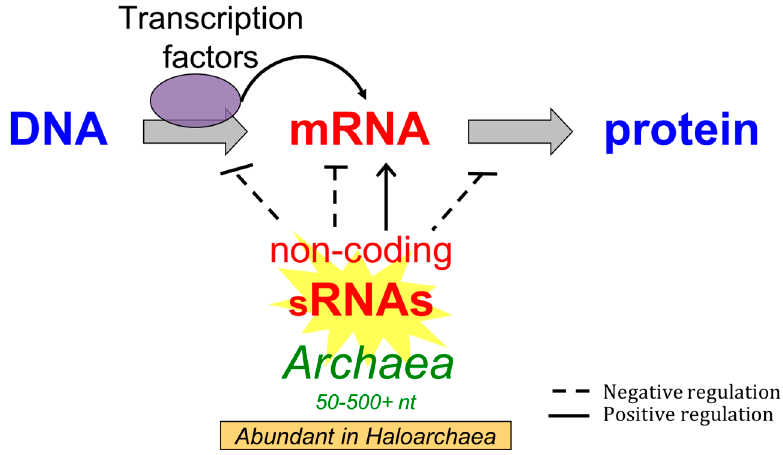
Figure 4. Correlation- and experimental-based regulatory mechanisms for sRNAs reported in the Archaea . The grey arrows indication the processes of transcription and translation. Regulatory arrows indicate regulation at transcription, post-transcription and translation steps.